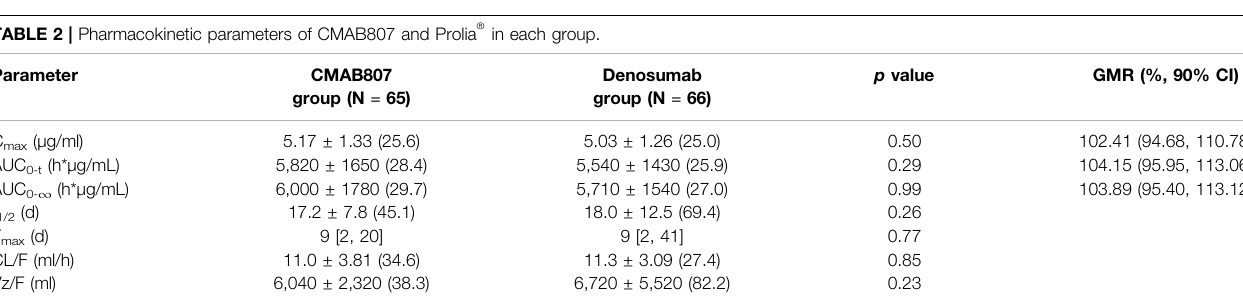
TABLE 2 | Pharmacokinetic parameters of CMAB807 and Prolia ® in each group.